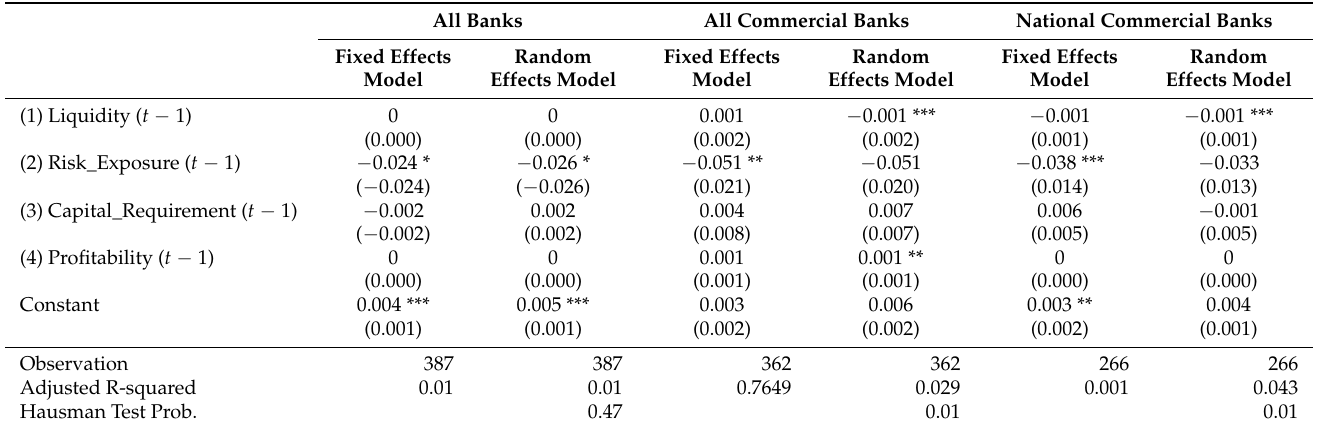
Table 10. Regression results of four variables in t − 1 (post-2017Q4).